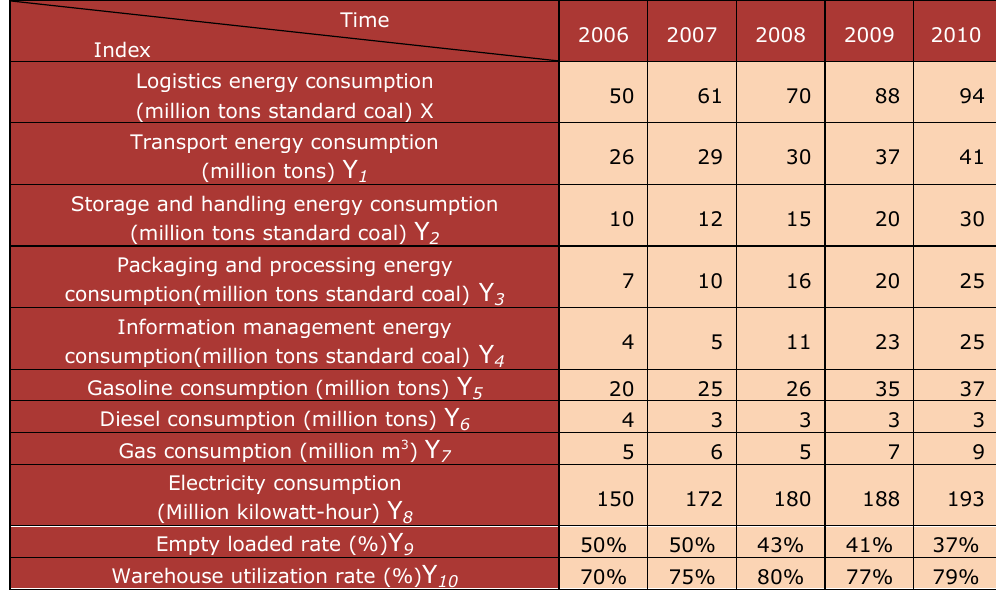
Tab.2 the original data table of logistics energy consumption and its related factors